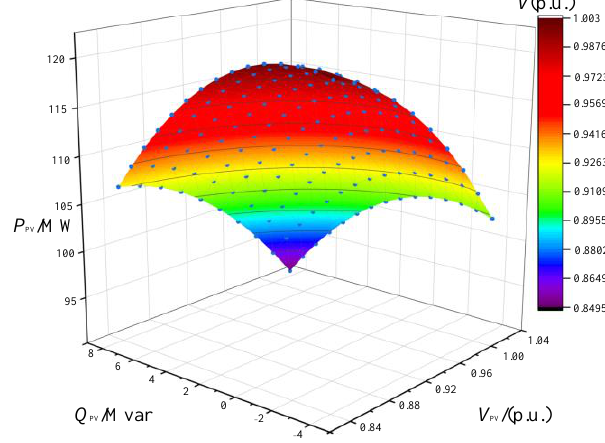
Figure 9. SSSR of G PV 59 PV power unit.